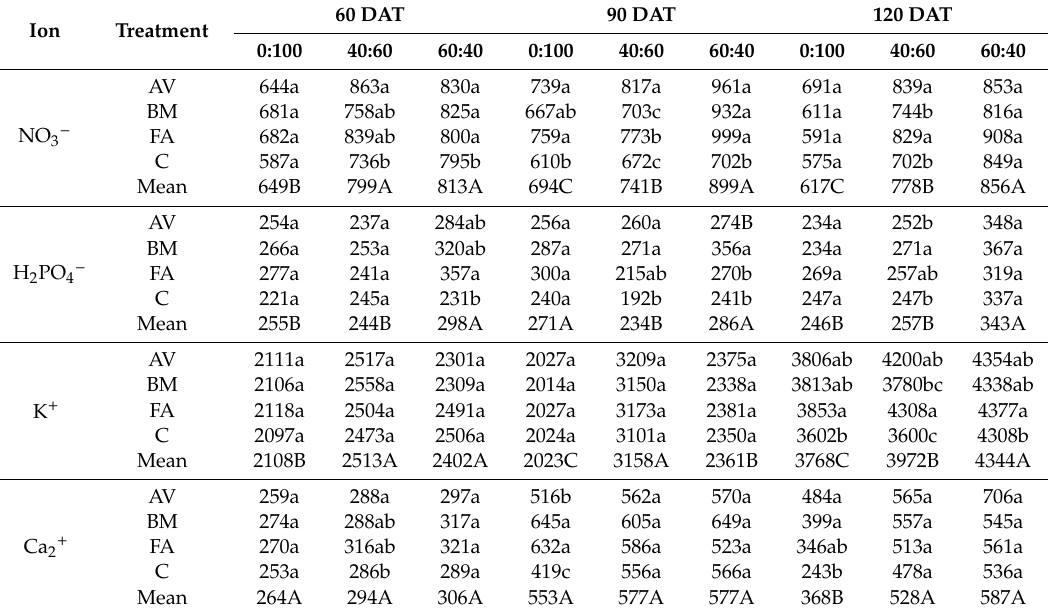
Table 8. Petiole cellular extract analysis for the tomato crop (mg L − 1 ). DAT, days after